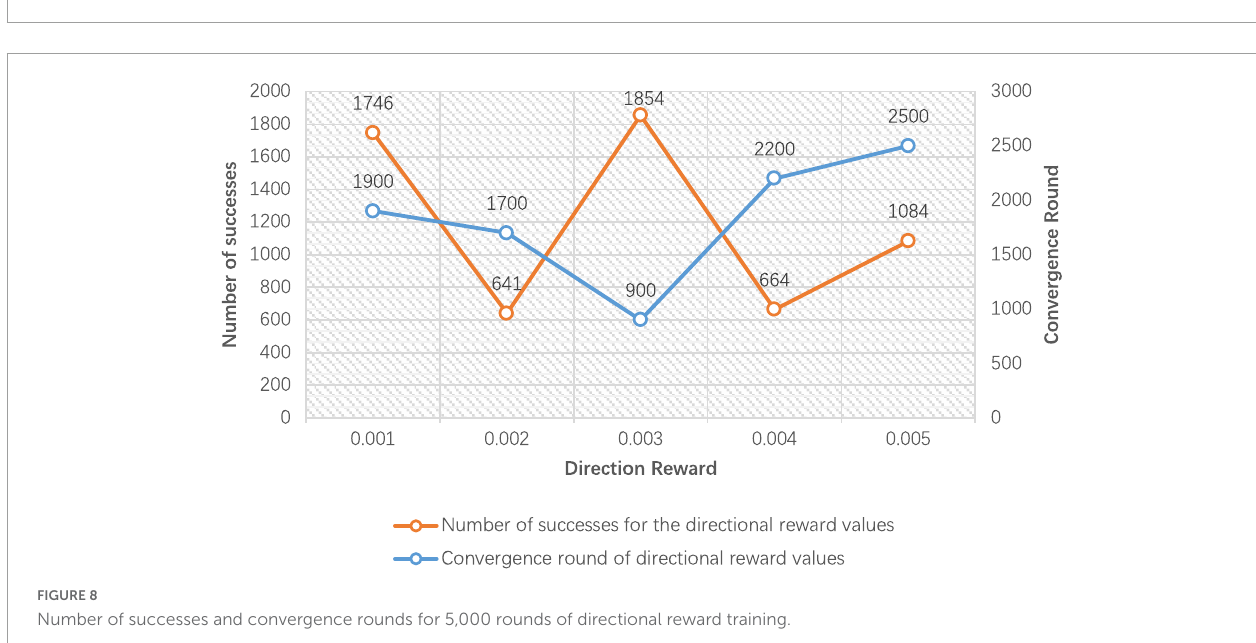
FIGURE7 Number of successes and convergence rounds for 5,000 rounds of sparse reward training.